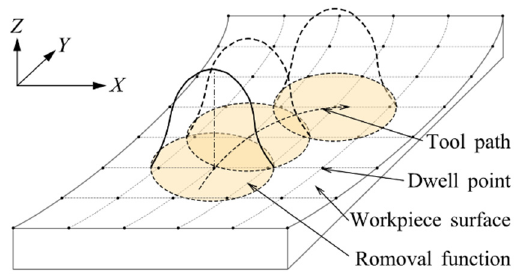
Figure A2. The schematic diagram of the material removal process of CCOS [253].